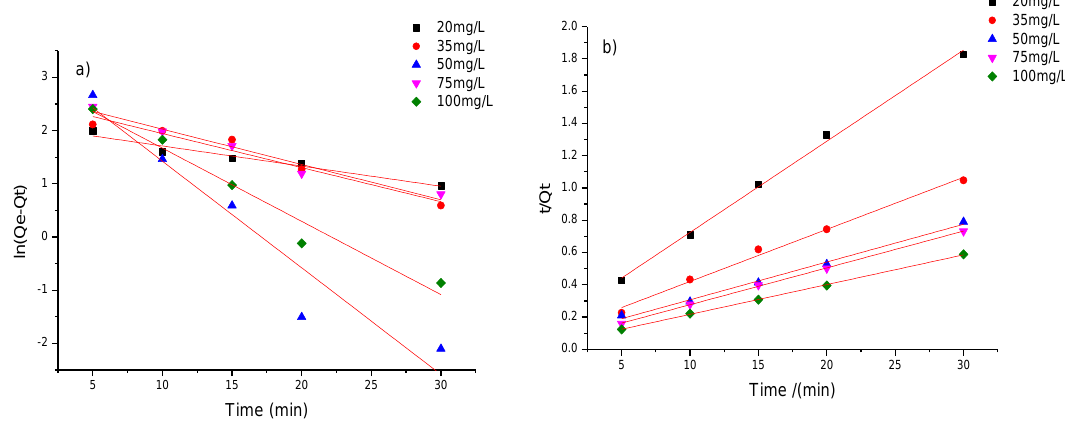
Figure 7. The linear fitting of Pseudo-first-order ( a ) and Pseudo-second-order ( b ) for removal of MB. Table 2. Kinetic parameters of different initial concentrations of MB. C 0 (mg/L)